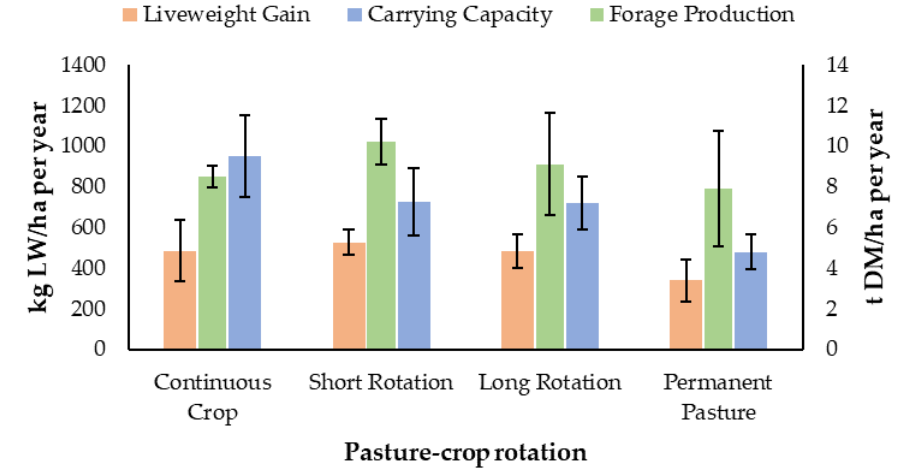
Figure 5. Forage production, liveweight gain, and carrying capacity of four different pasture–crop rotations (‘Palo a Pique’ long-term experiment, 1996–1999). Adapted from Terra and García-Préchac [14].